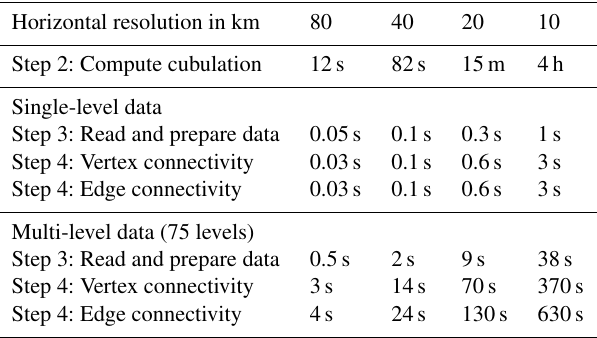
Table 2. Times required for different aspects of TriCCo’s Python implementation for different sizes of the triangular grid. The times are obtained from benchmarks on the DKRZ Levante supercomput- ing